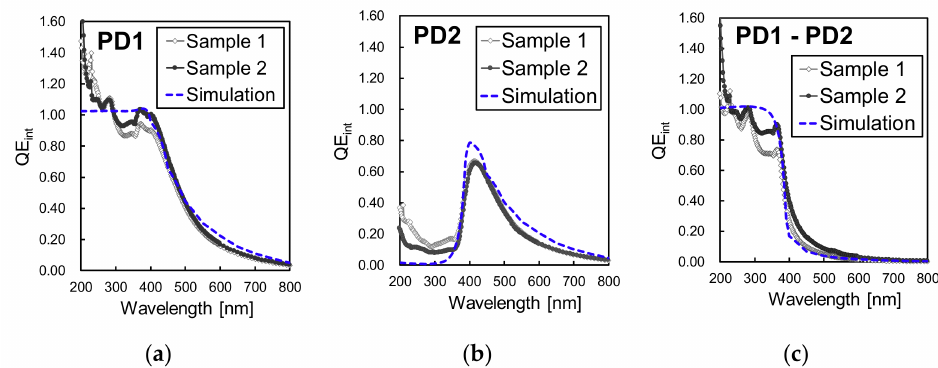
Figure 11. Comparison of the internal quantum e ffi ciency ( QE int ) between the measurement results of samples 1 and 2 and the simulation results, for ( a ) PD1, ( b ) PD2 and ( c ) di ff erential spectral response PD1 –